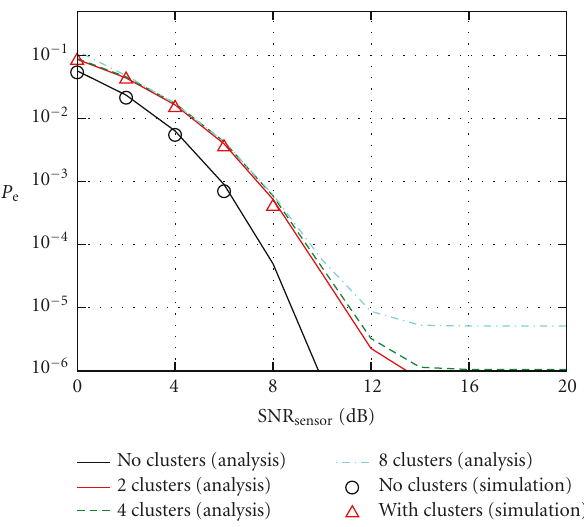
Figure 14: CDF of the network lifetime, as a function of time, in a scenario with N = 64 sensors, uniform clustering, and noisy com- munication links. Two possible values for the crossover probability are considered: (i) p = 0 . 1 and (ii) p = 0 . 001. The sensor SNR is set to 5dB and the maximum tolerable probability of decision error = 10 − 3 . For comparison, the curve relative to ideal commu- is P ∗ e nication links is also shown. The distribution of a sensor lifetime is